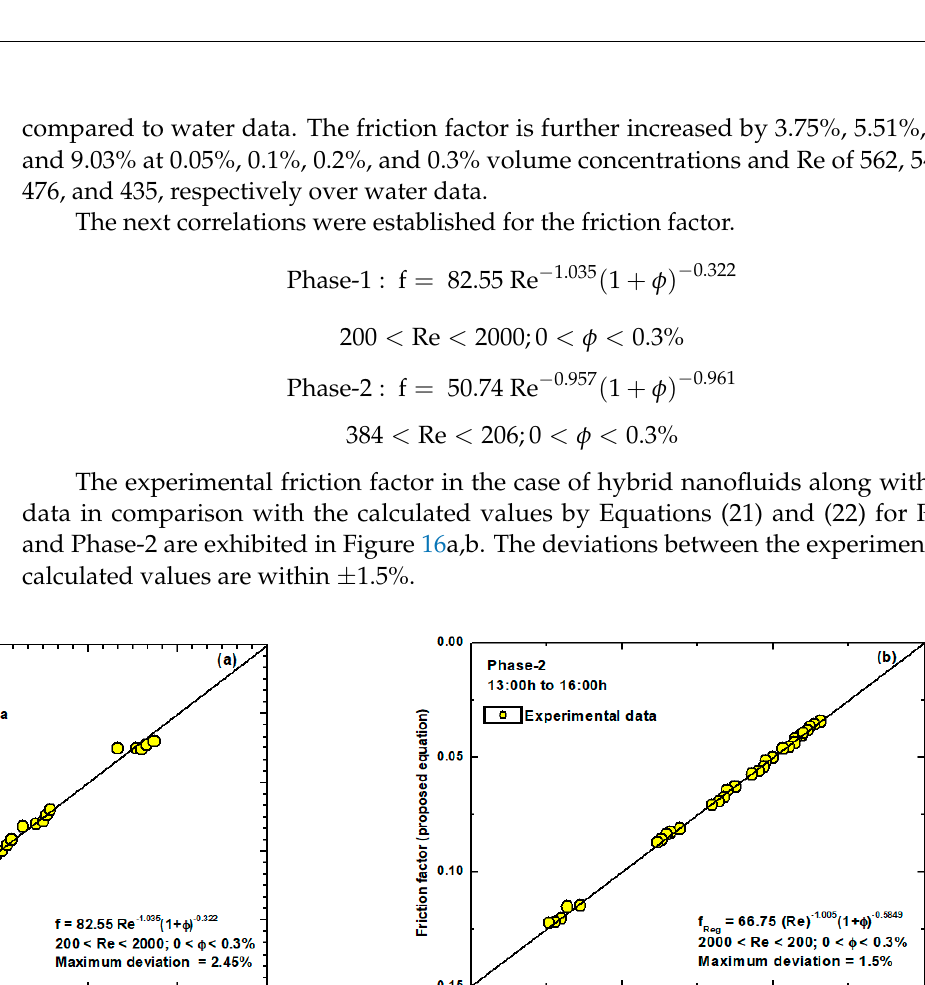
Figure 15. The hybrid nanofluids experimental friction factor; Phase-1 ( a ), and Phase-2 ( b ). Figure 15b represents the friction factor of hybrid nanofluids at different Re in